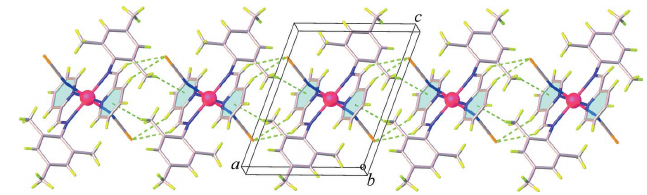
Fig. 4. The chains are further linked into a three-dimensional